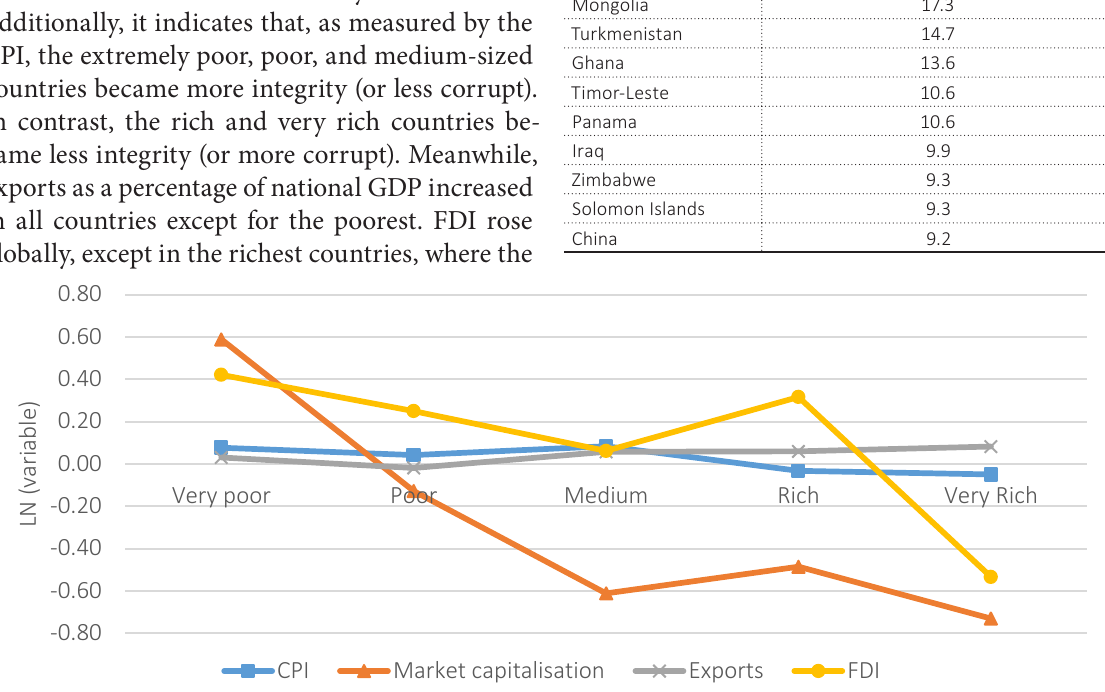
Figure 2. Interactions between changes in the values of measures and